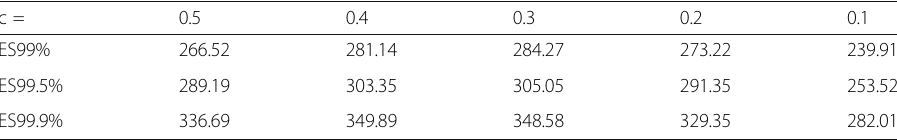
Table 2 Expected Shortfall under several ambiguity levels c = 0.5 0.4 0.3 ES99%